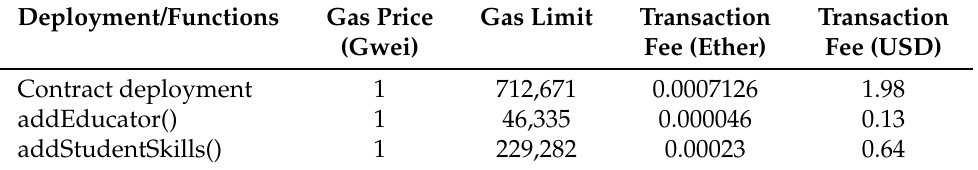
Table 2. Transaction fees on skillsChain.